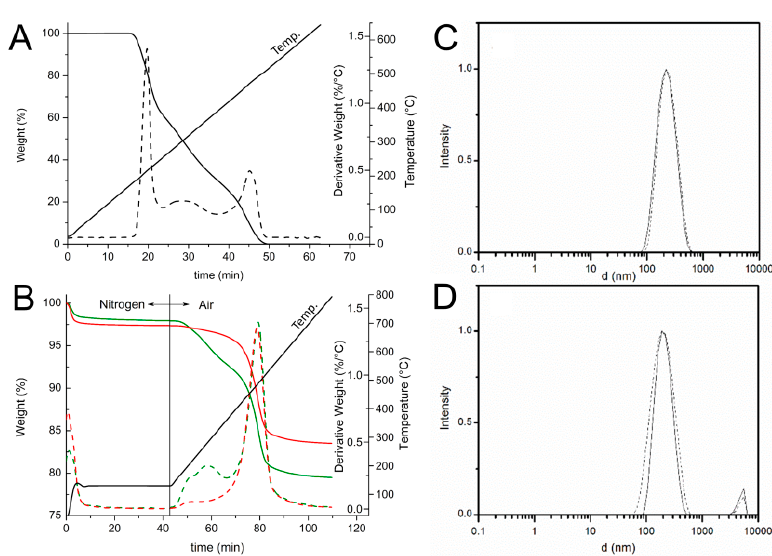
Table 1. TGA data of pristine (HNT) and modified (HNT/AH 2 ) halloysite, along with plain ascorbic acid (AH 2 ) and reference AH 2 +HNT physical mixtures.